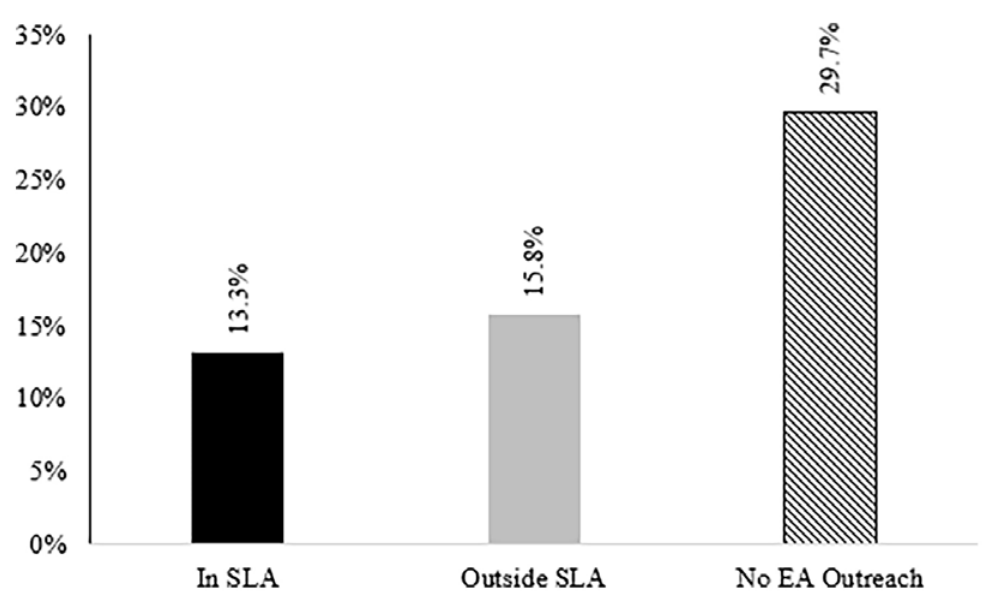
Figure 2. Drop Rate by Service Level Agreement